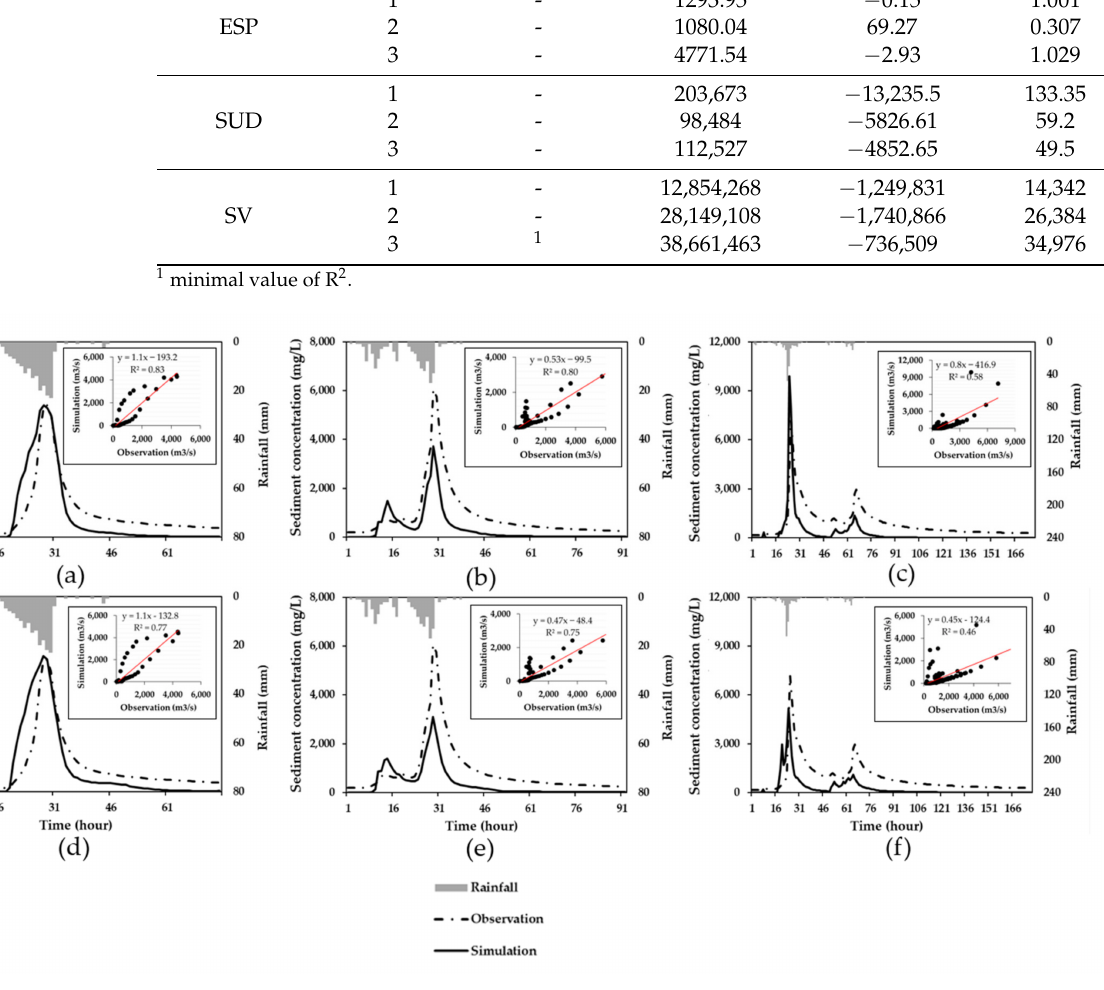
Figure 5. Comparison between simulation and observation of sediment concentrations in Cheoncheon basin with the KR method in Event 1 ( a ), Event 2 ( b ), and Event 3 ( c ); with the EH method in Event 1 ( d ), Event 2 ( e ), and Event 3 ( f